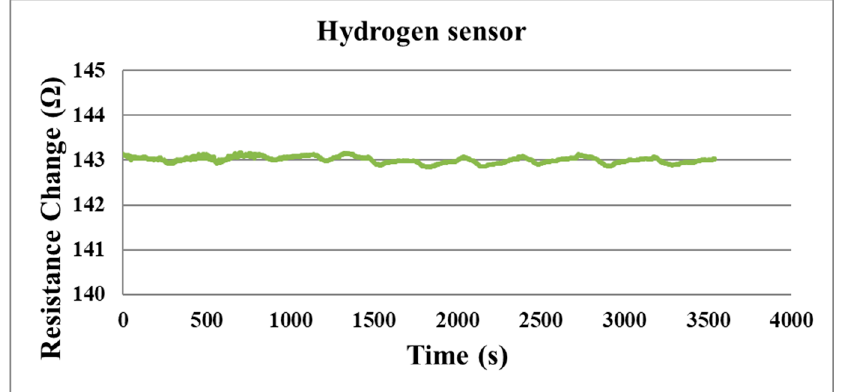
Figure 18. The hydrogen side’s hydrogen detection.